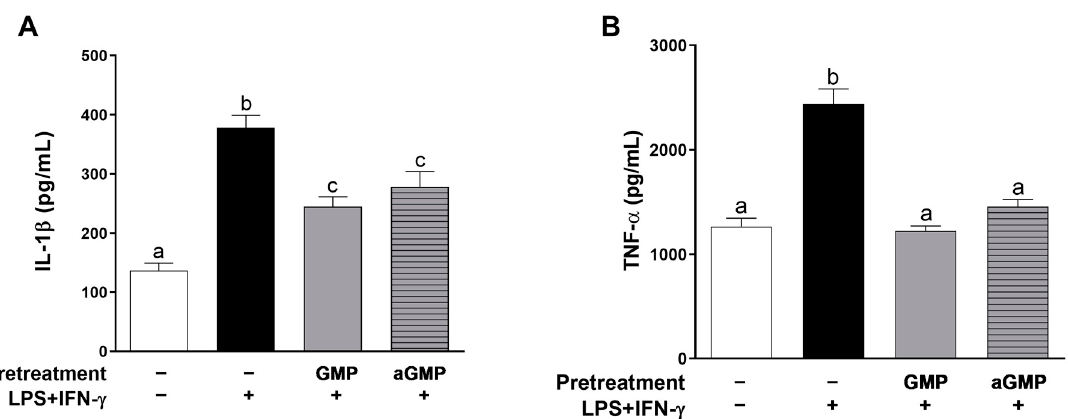
Figure 4. Effect of GMP and aGMP on the secretion of inflammatory cytokine by stimulated U937 macrophages. Cells were incubated (pretreated) in the absence or presence of GMP (2.5 µ g/ µ L) or aGMP (2.5 µ g/ µ L) for 12 h and later stimulated with LPS (10 µ g/mL) and IFN- γ (20 ng/mL) for 24 h. ( A ) IL-1 β and ( B ) TNF- α were quantified on supernatants by ELISA ( n = 6, 2 independent experi- ments in triplicate). Means followed by di ff erent le tt ers (a, b, c) are signi fi cantly di ff erent.